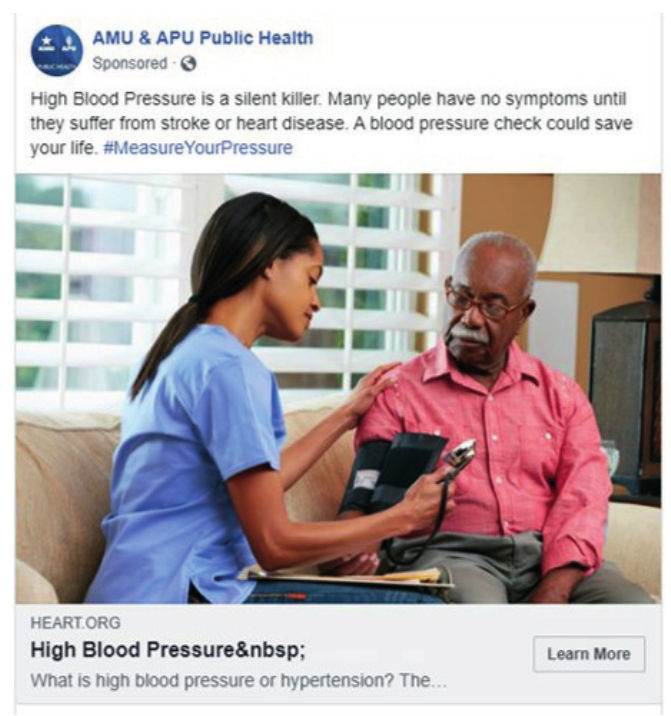
Figure 1. Facebook ads-Learn more, (Measure Your Pressure) MYP 1-General and MYP 1-AA.